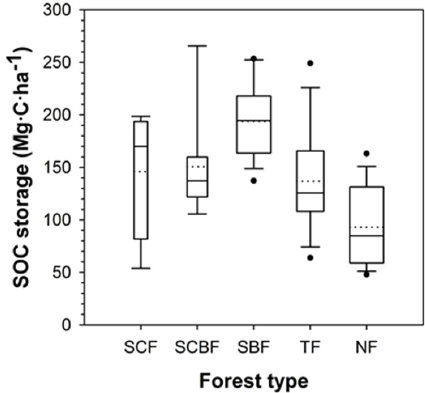
Figure 7. Box plot of SOC stocks of different forests in 0–100 cm soil profiles; box length denotes interquartile range; box width denotes sampling size; whiskers denote range of variability; solid lines denote median; dotted lines denote mean.